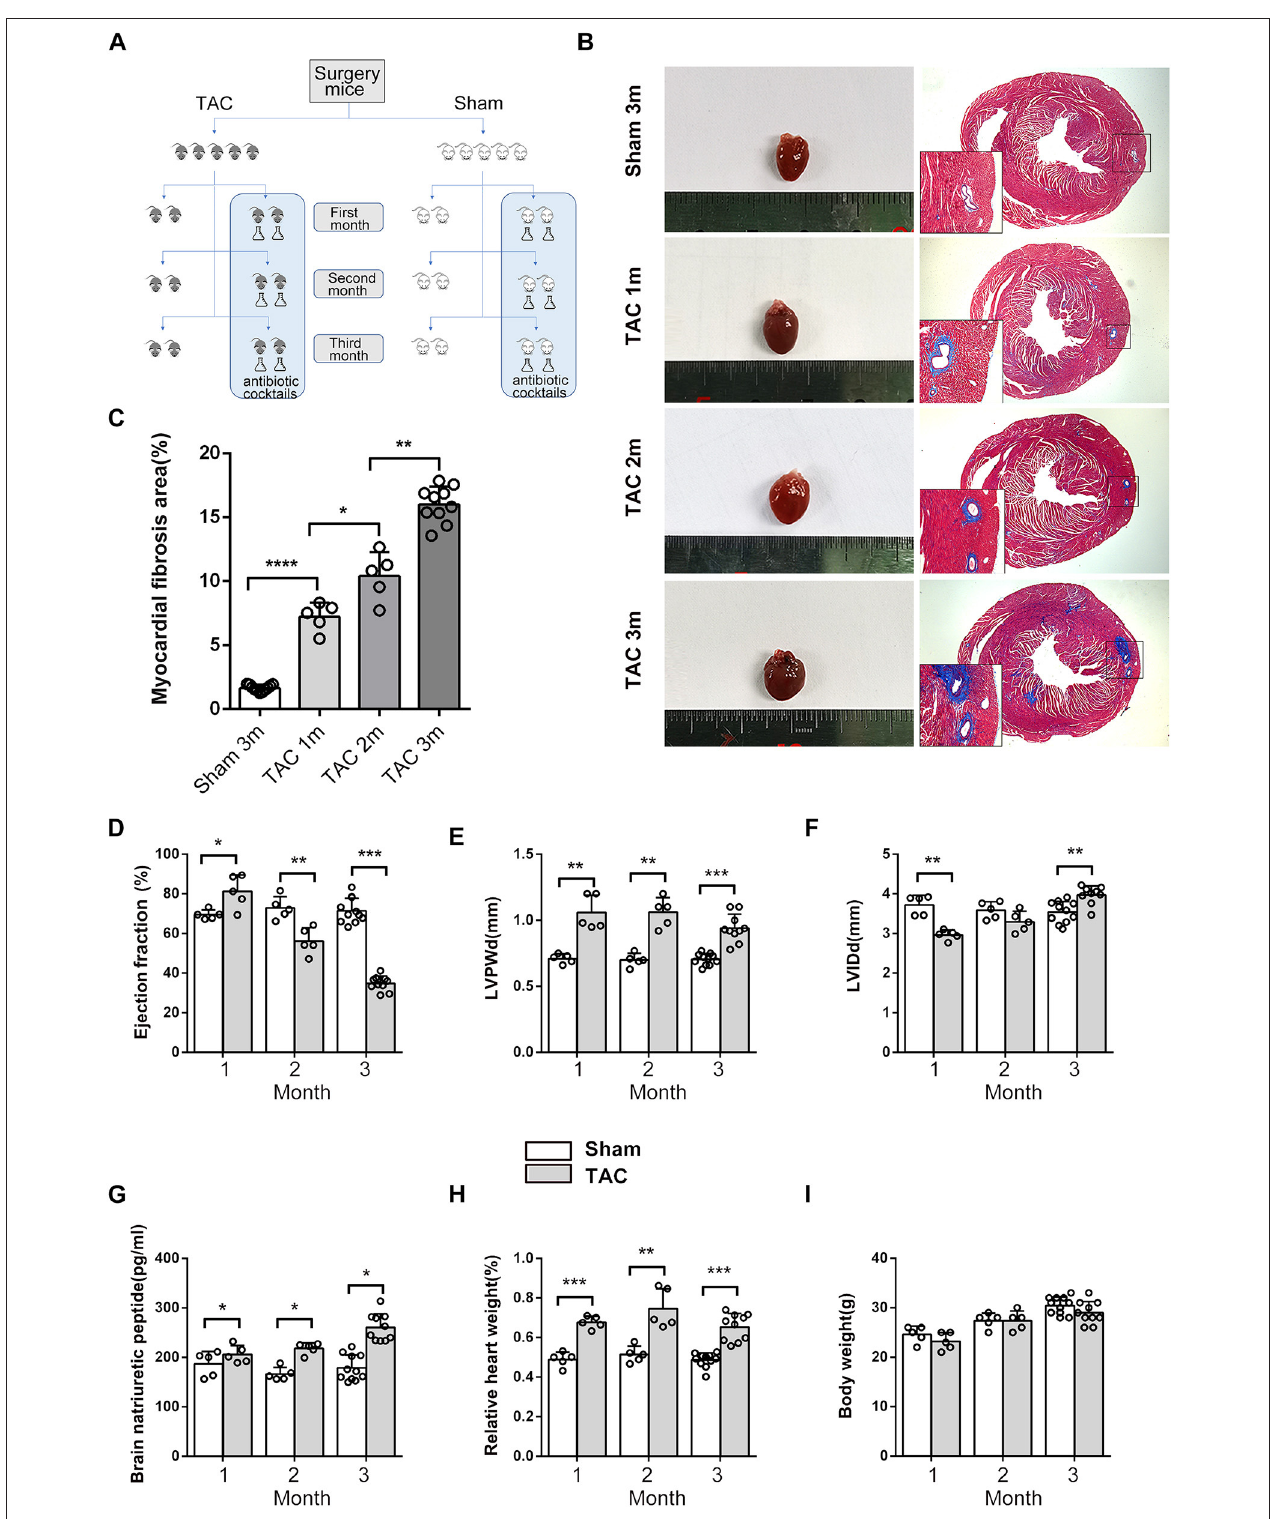
FIGURE 1 | Cardiac morphometry and function during the 3 months after surgery. (A) Schematic diagram of the study design. (B,C) Cardiac size and cardiac fibrosis as shown by Masson’s Trichrome Staining. (D) Heart function was determined based on transthoracic echocardiographic examination and ejection fraction (EF). (E) Left ventricular posterior wall dimensions at end-diastole (LVPWd). (F) Left ventricle end-diastolic dimensions. (G) Serum brain natriuretic peptide (BNP) levels. (H) Relative HW. (I) Body weight (BW). n = 5–11. * p < 0.05, ** p < 0.01, *** p < 0.001.